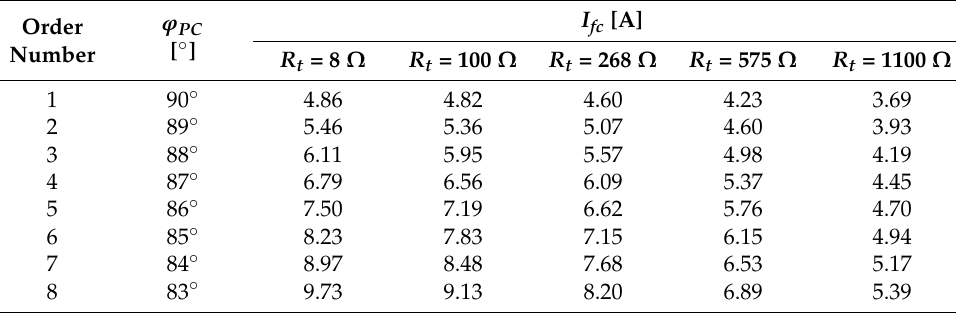
Table 6. Effective value of the fault current depending on ϕ PC , when ϕ c = 86 ◦